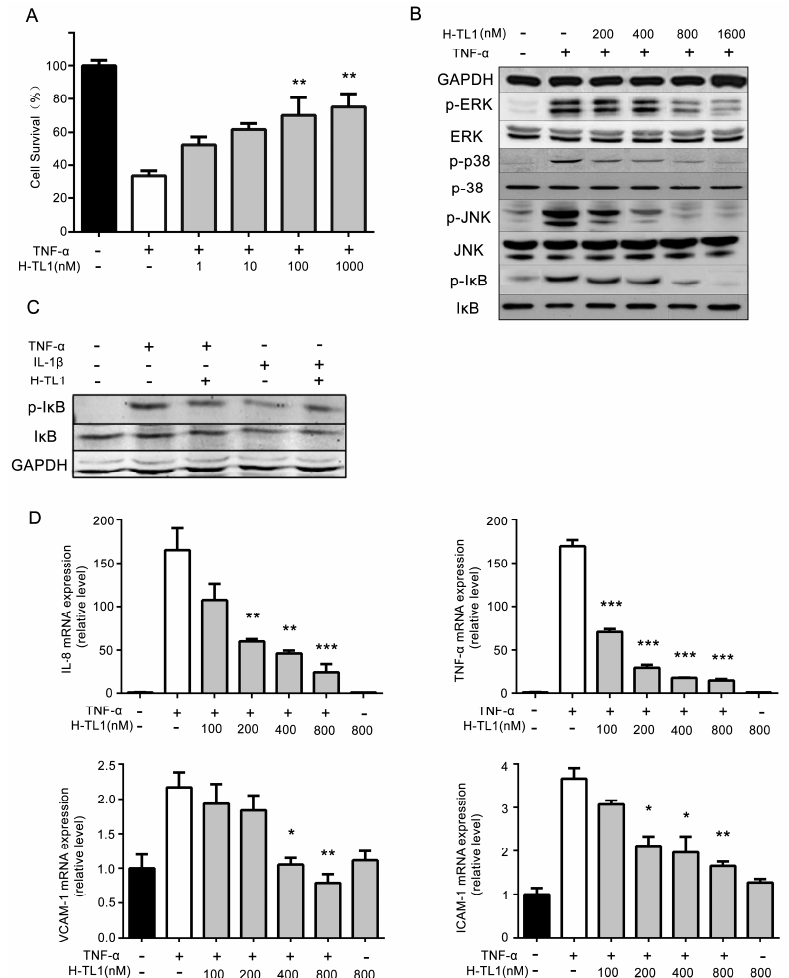
Figure 2. H-TL1 reduced the effects of TNF- α in vitro: ( A ) H-TL1 improved survival in TNF- α -treated L929 cells; ( B ) H-TL1 inhibited the TNF- α -induced phosphorylation of p38 (Thr180/Tyr182), ERK (Thr202/Tyr204), JNK (Thr183/Tyr185), and I κ B (Ser32/36) within the NF- κ B and MAPKs signaling pathways; ( C ) H-TL1 failed to inhibit the phosphorylation of I κ B induced by IL-1 β ; and ( D ) H-TL1 inhibited TNF- α -mediated expression of pro-inflammatory factors. HEK293 cells were stimulated with TNF- α (20 ng/mL) for 10 min with graded concentrations of H-TL1. Values represent means ± SEM (A: n = 5; D: n = 3), * p < 0.05, ** p < 0.01 and *** p < 0.001 vs. TNF- α group.